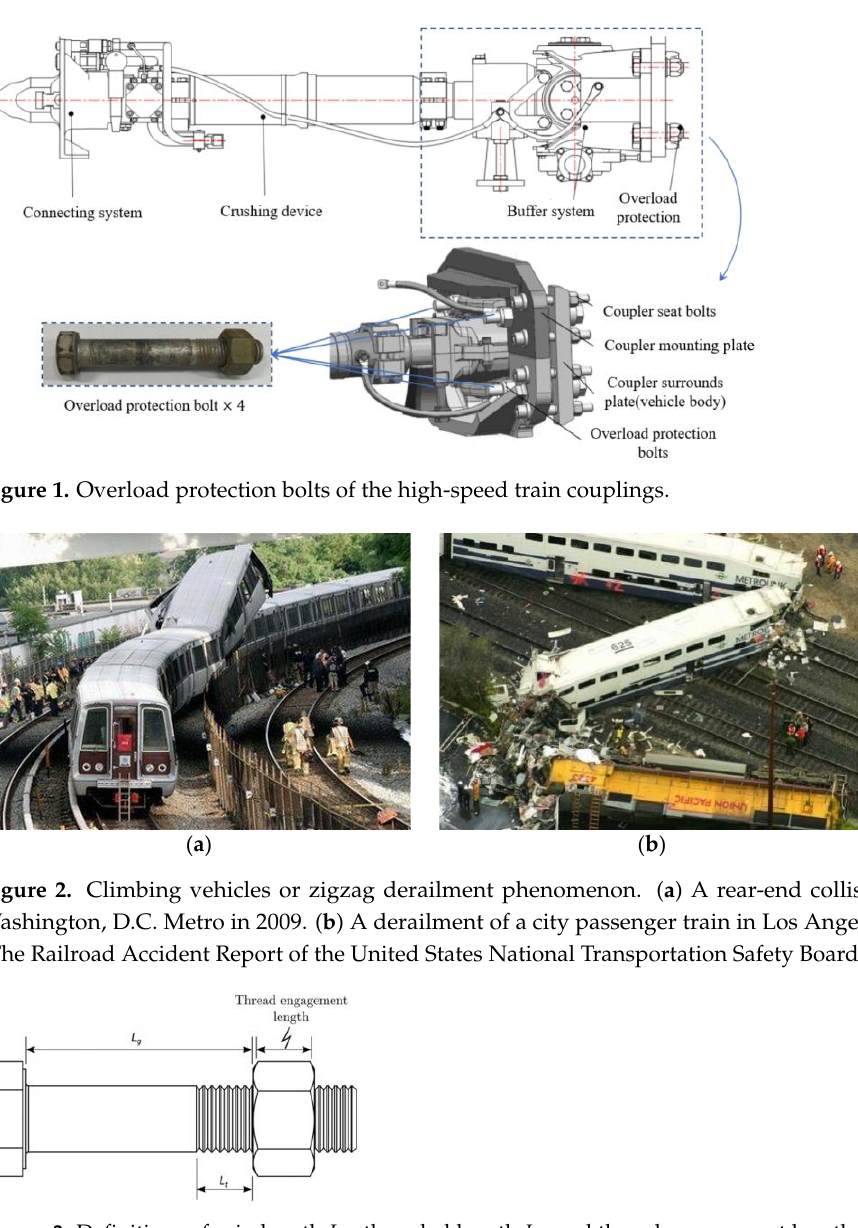
Figure 3. Definitions of grip length L g , threaded length L t , and thread engagement length. Reprinted with permission from [12], 2023, Elsevier.